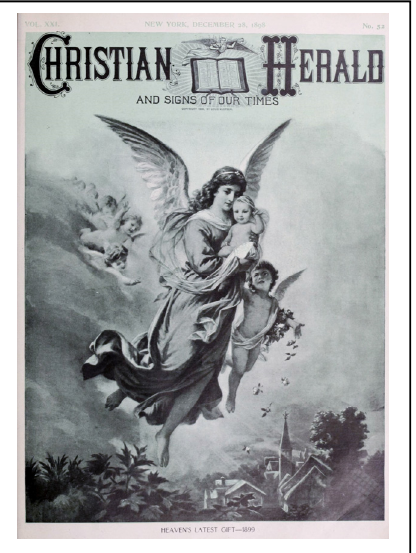
Figure 9. A Christian Herald Angel. Christian Herald , 28 December 1898. Meanwhile, as the new century approached, topics like premillennialism and divine healing receded, not discarded but deemphasized as the Herald highlighted enterprises still capable of uniting diverse parties within an increasingly divided movement, such as philanthropy and missions. 66 This theological repositioning might read like an effort to hold a seat at the table of elites even as new and disreputable views like dispensationalism loosened the Evangelical grip. The reality was far more complex. Dispensationalism was nothing new for the Herald , and though shifting norms regarding the ideas deemed cred- ible and behaviors deemed admissible in polite society may have played a role, a closer look reveals the greater relative importance of intra-Evangelical dynamics. By the late nineteenth century, Evangelicalism was already being torn from within, having attempted a reach too wide to hold. 67 In hindsight, we can recognize the first full breach in a steady stream of defections throughout the 1880s and 1890s as Holiness “comeouters” forsook established denominations for a network of independent churches and associations. Cultural impulses deeper than doctrine played an outsized role in this schism, as plainfolk militants, agents in an anti-elitist revitalization movement that harked back to the “democratic” revivalism of a prior era, seized the banner of “Pentecostal” re- ligion and lampooned the bourgeois strains of piety found in places like the Christian Her- ald as the “polar snow fields of tame holiness”. 68 Their actions provoked an opposite if not quite equal reaction among Evangelical moderates. For example, their bumptious em- brace of premillennialism brought pressure on the Herald to retreat from it. The situation had deteriorated so badly by 1897 that a reader could ask, “Are there any men of common